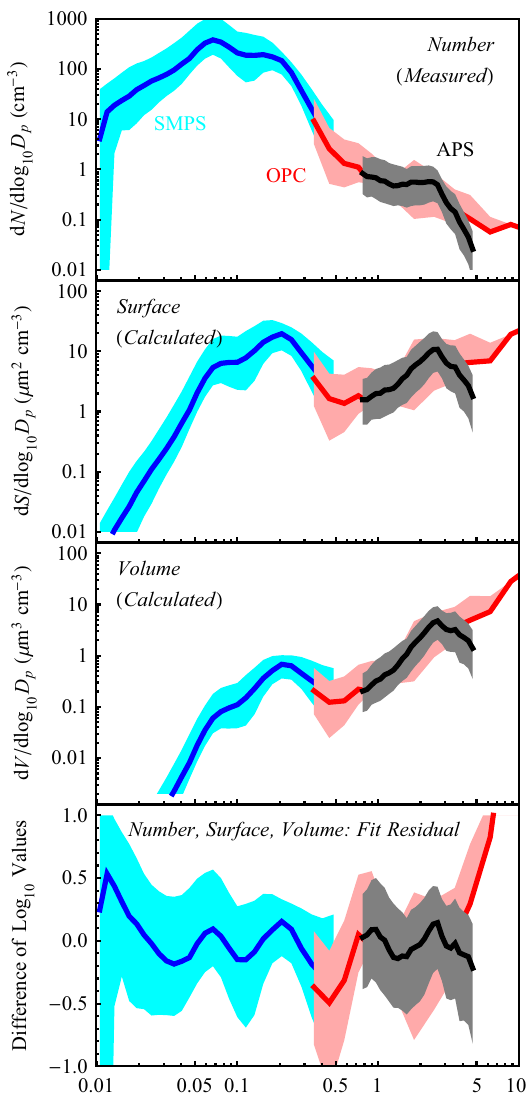
Fig. 12. The top panel shows the measured number-diameter distribution dN/d log D p from 10nm to 10µm for 6 to 14 March 2008. The distribution is a composite of measurements from a scanning mobility particle sizer (SMPS), an optical particle counter (OPC), and an ultraviolet aerodynamic particle sizer (UV-APS). The central lines show the median during the time period, and the shaded regions represent the 10- and 90-percentiles of the distribution of observations. Shown in the middle panels are the surface-diameter and volume-diameter distributions calculated from the number-diameter distribution. The bottom panel shows the difference of log 10 values between measurement and calculation (i.e., the residual) for the lognormal parameters given in Table 3. The residuals of log 10 values are identical for number, surface, and volume distributions.